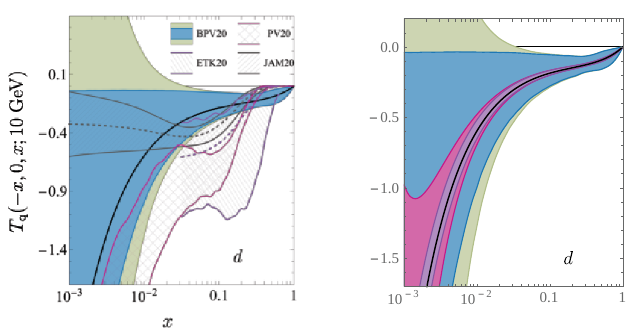
Figure 3. The d -quark contribution to the Qiu-Sterman function extracted from the collinear limit of the Sivers function. The existing determinations are summarized on the left panel (adapted from [36]). The projected accuracy for EIC is shown in magenta on the right panel (EIC impact studies, courtesy of A.